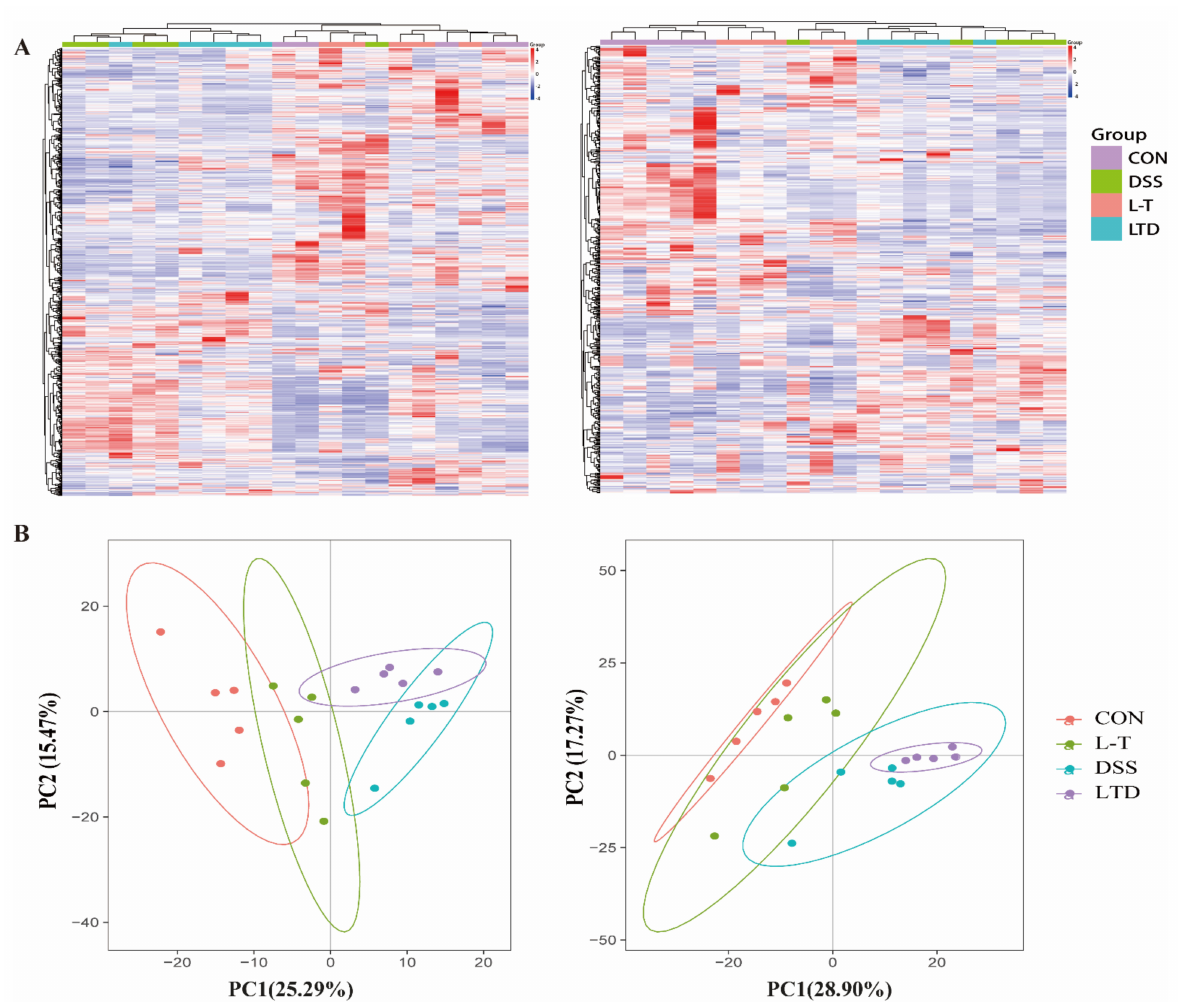
Figure 3. Hierarchical clustering analysis (HCA) ( A ) and principal component analysis (PCA) ( B ) of the differences on cellular metabolites among CON, L-T, DSS and LTD groups ( n = 5) based on mass spectrometry data acquired in both positive and negative ionization